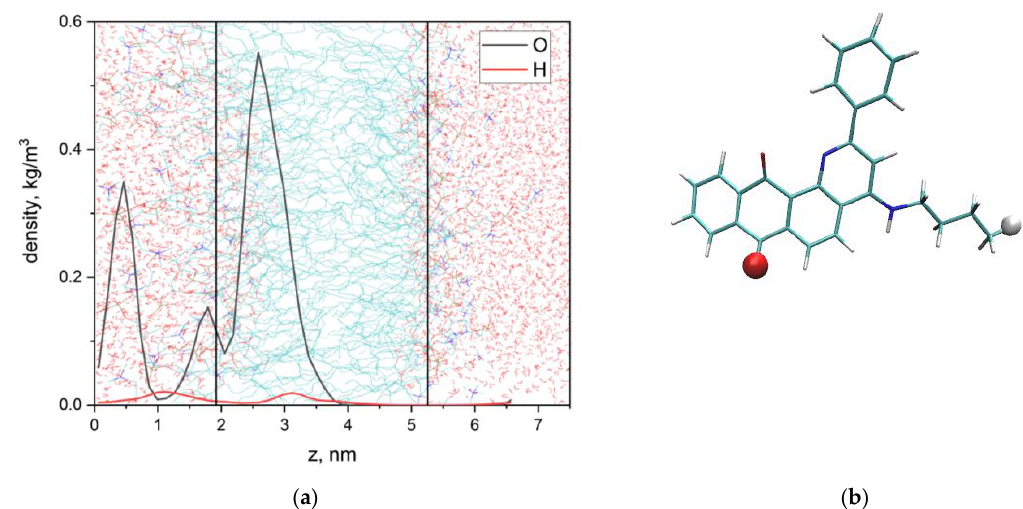
Figure 7. Density profiles of the selected O and H atoms of Q1 ( a ) and atom selections ( b ). Vertical lines correspond to the centers of density profiles of DMPC N-atoms. Q1 molecule could freely rotate in the bilayer, but the angle between the tricyclic ring (containing quinoid groups) vector and the bilayer normal was predominantly about 100° (Figure 8). The orientation of Q1 in the lipid bilayer is similar to other anthraquinones, which is oriented perpendicular to the bilayer normal [2]. Such an orientation could result in significant changes in lipid packing, which could, in turn, influence lipid mobility.